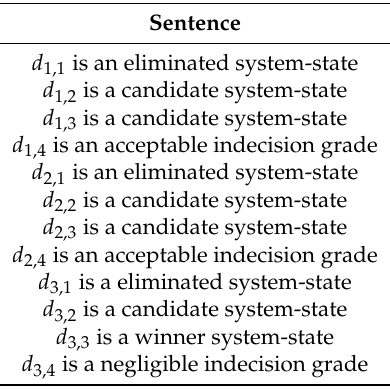
Table 4. Semantic